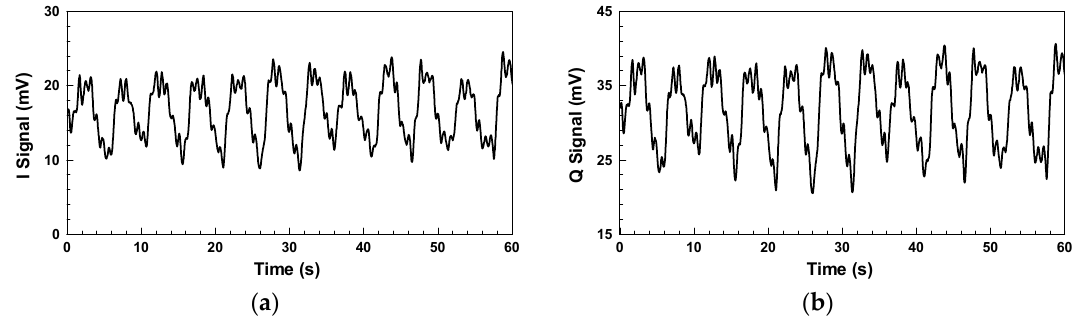
Figure 4. Baseband signals for non-contact vital sign detection using the conventional CW radar: ( a ) I signal; ( b ) Q signal.